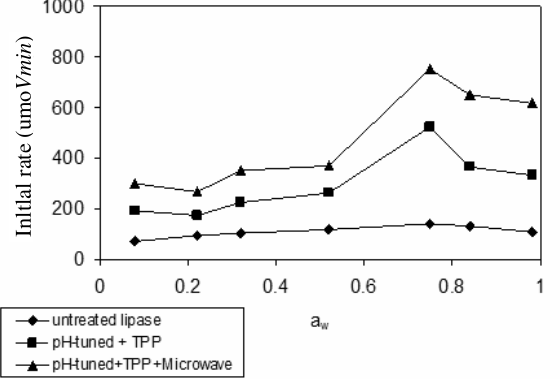
Figure 1. Initial rates of Candida rugosa lipase, untreated, pH-tuned plus TPP-treated and pH-tuned plus TPP treated plus microwave irradiated, at various water